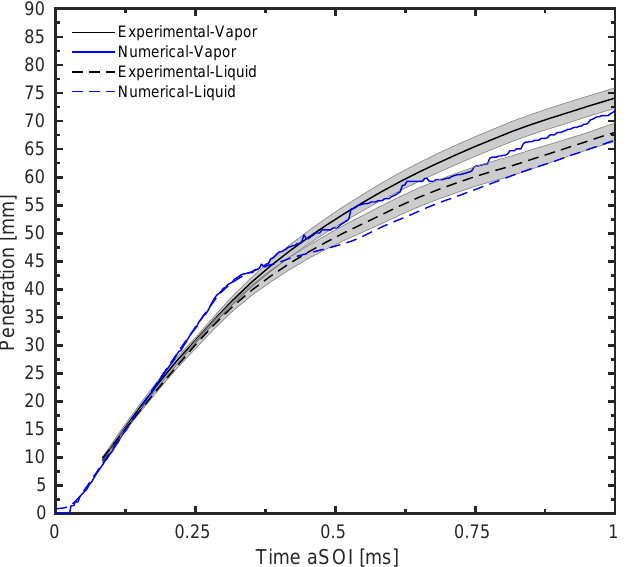
Figure 14. Numerical and experimental axial vapor and liquid phases penetration for the G2 cold condition for